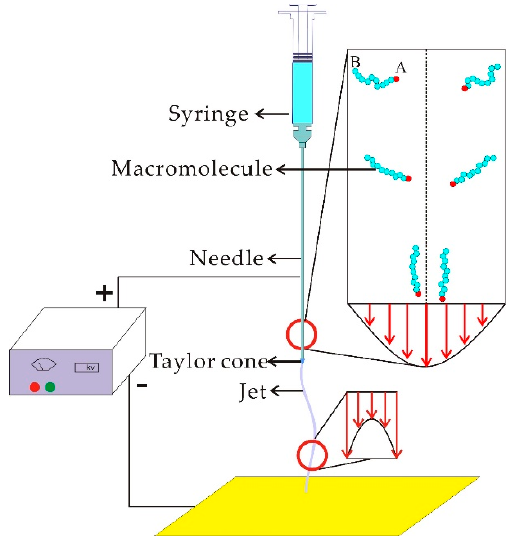
Figure 1. Electrospinning spinning controlled by the laminar flow in the long needle. The macromolecules in the needle will be gradually stretched and moved to the center along the line of flow (streamline); in contrast, the macromolecules in the jet move gradually outwards.